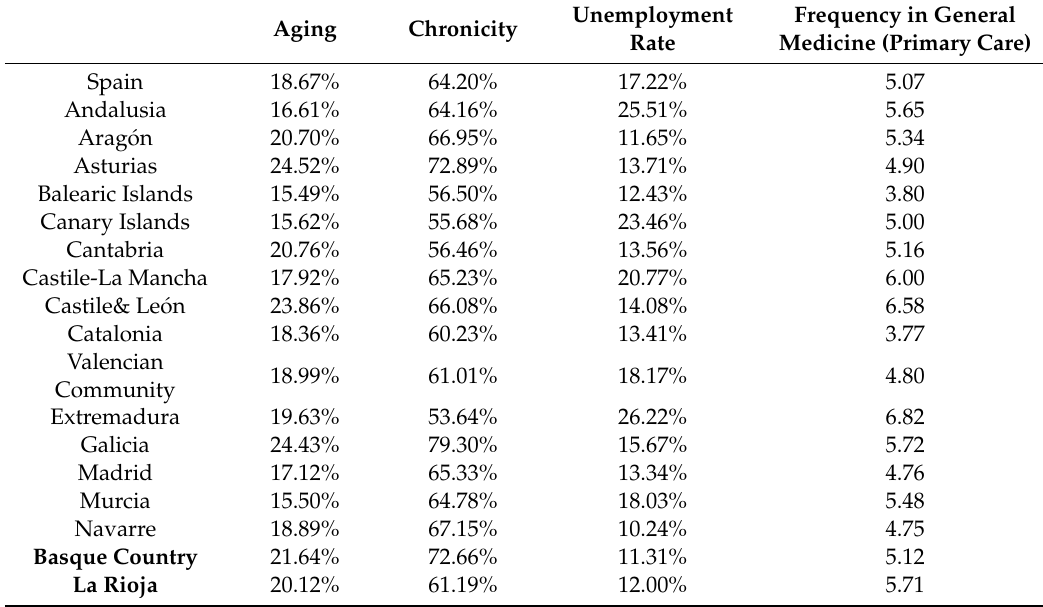
Table 1. Analysis of aging, chronicity, unemployment rate, and level of income and frequency in general medicine and pediatrics.